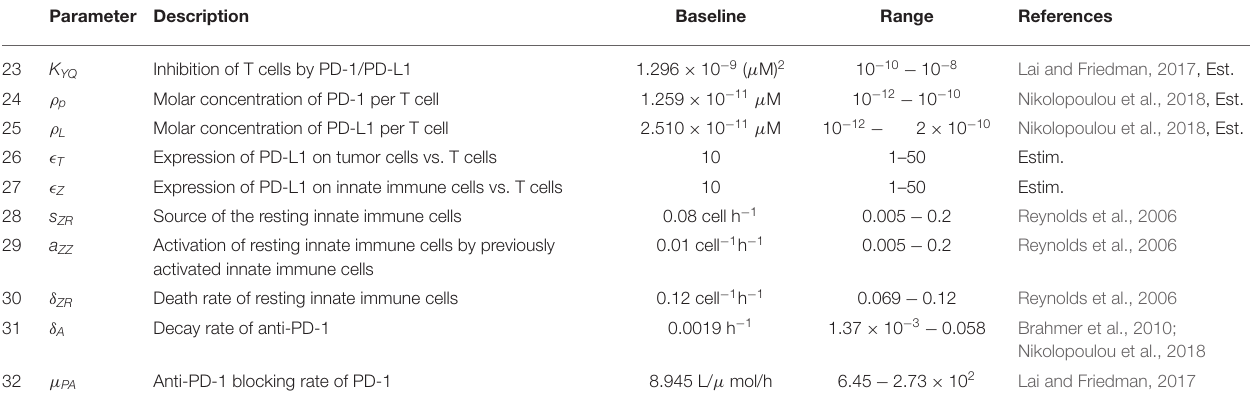
TABLE 3 | Parameters used in immune